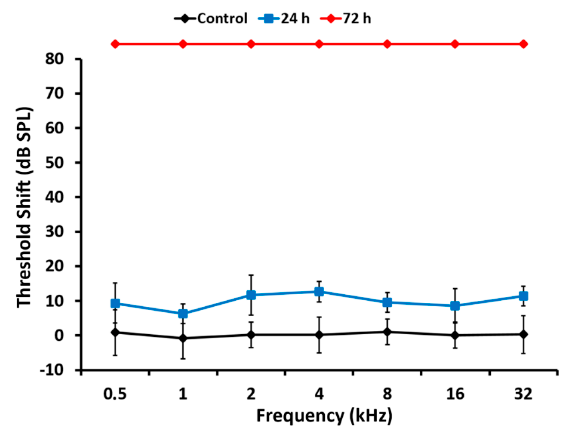
Figure 2. Auditory threshold shifts after 24 h and 72 h of intraperitoneal cisplatin administration (single dose of 16 mg/Kg). Relative to control rats, there are slight, statistically non-significant threshold shifts after 24 h of the injection. In contrast, after 72 h, thresholds are not detectable at any tested frequency. Values are expressed as mean ± SD.